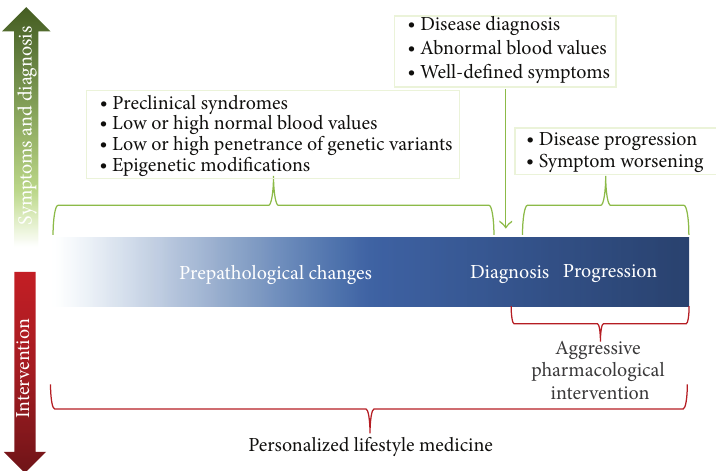
Figure 2: The trajectory of disease and role for personalized lifestyle